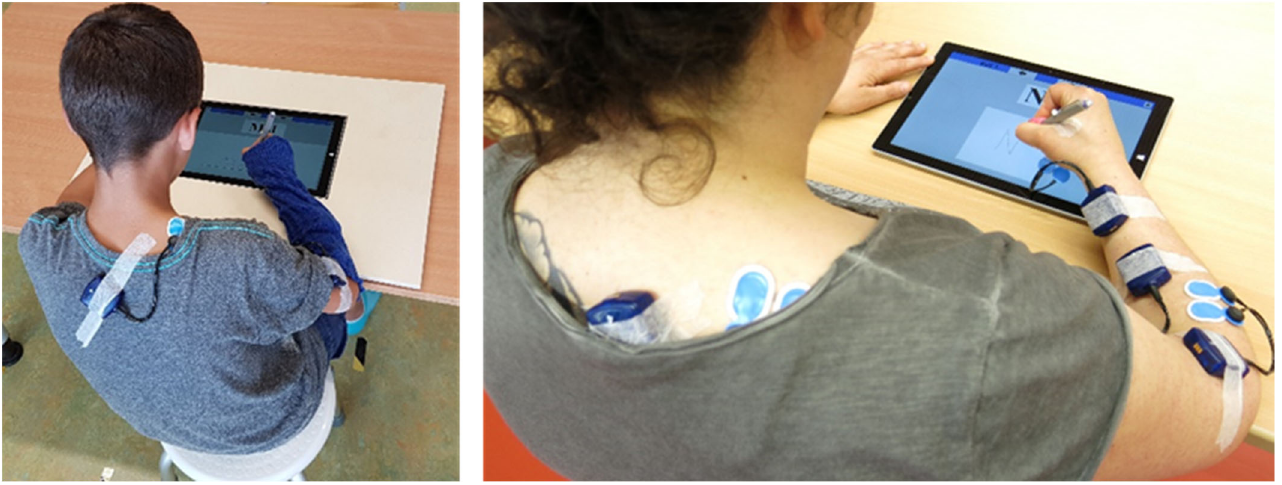
Figure 2. Writing on the tablet with electrodes placed on arm and shoulder ( left picture: child; right picture: adult).